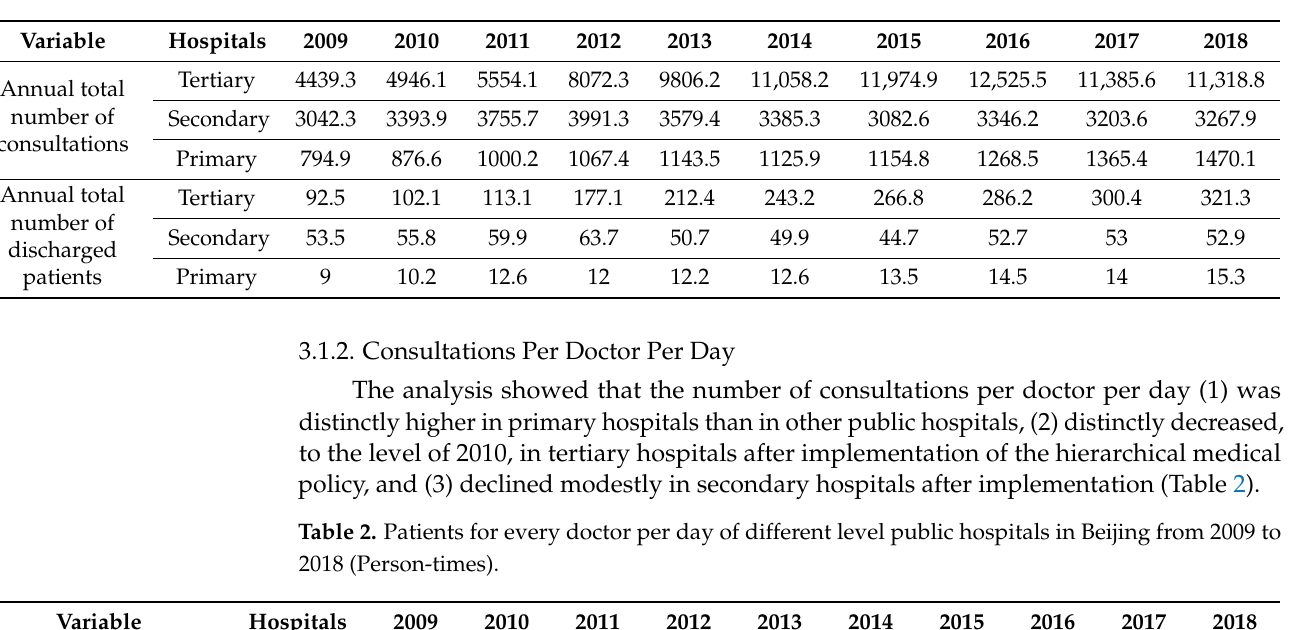
Table 1. Annual total number of patients and discharged patients of different level public hospitals in Beijing from 2009 to 2018 (10,000 person-times).